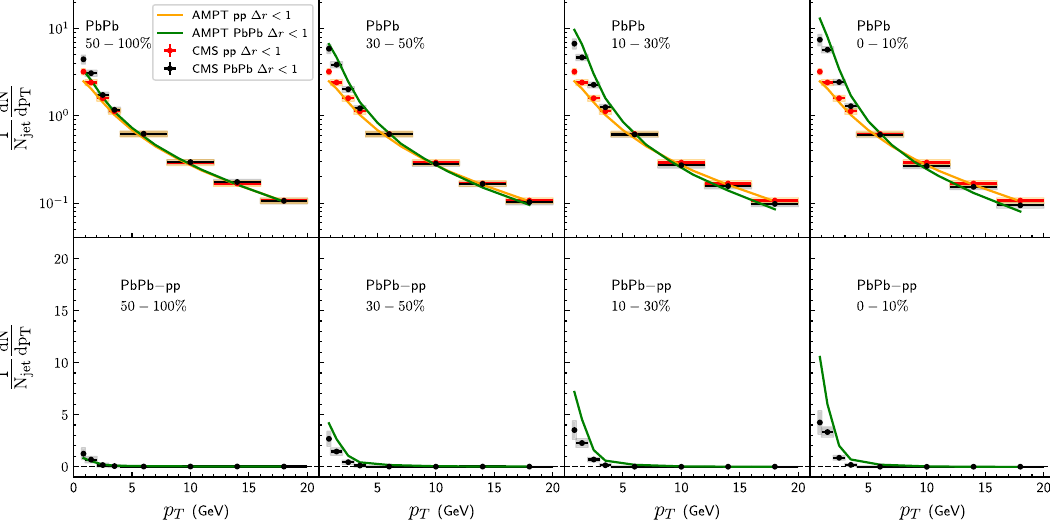
are shown in the lower panels. Four Pb + Pb collision centralities are shown:0 − 10% , 10 − 30% , 30 − 50%,and50 − 100%.Jetsaretakenwith > 120 GeV, R = 0 . 4 and | η | < 1 . p jet jet T